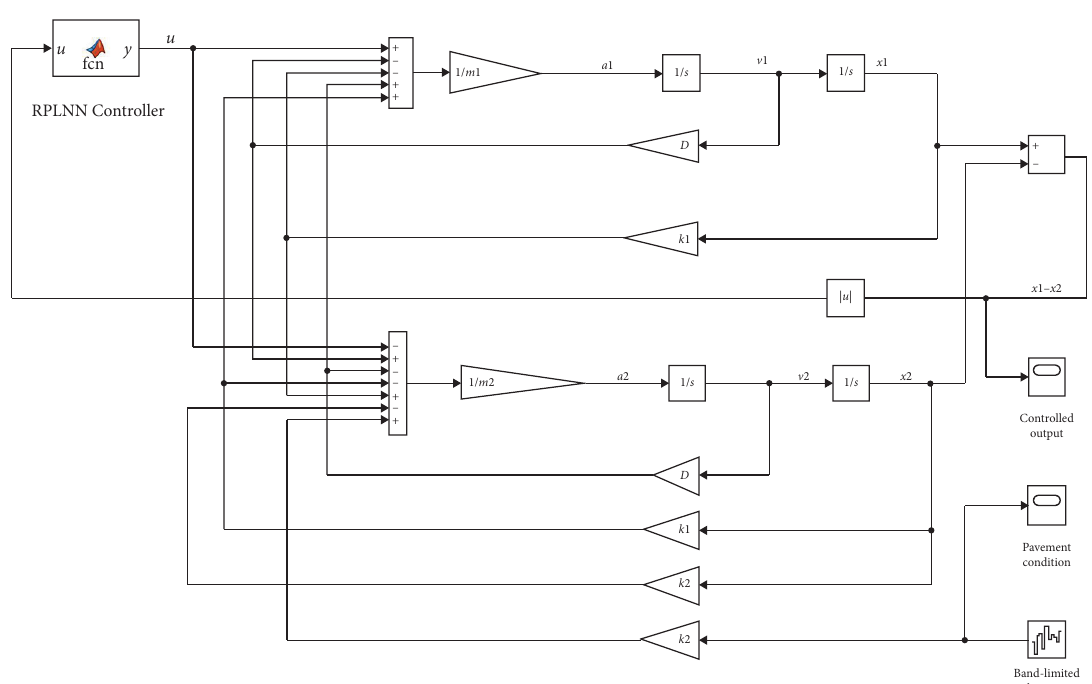
Figure 3: MATLAB Simulink Model of the Noise Cancellation system for the quarter car